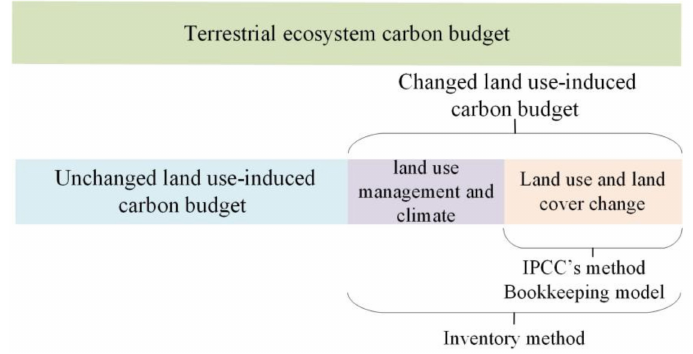
Figure 6. Composition of the terrestrial ecosystem carbon